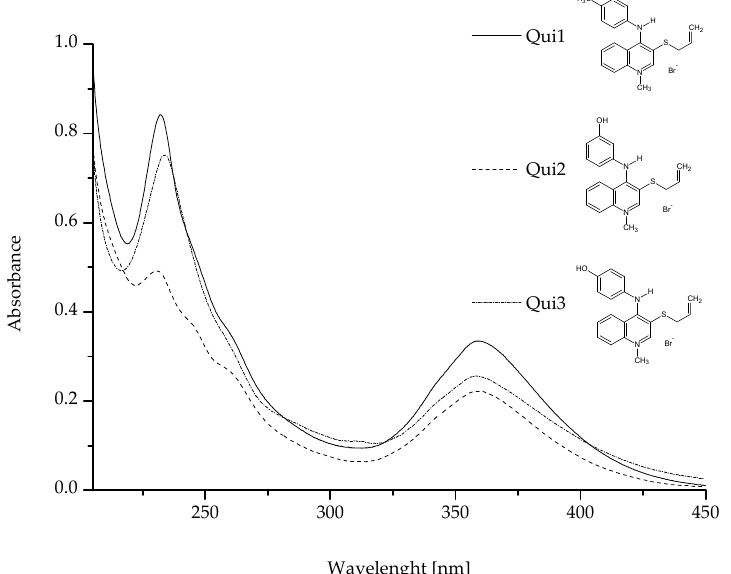
Figure 1. The absorption spectra of Qui1, Qui2 and Qui3 at 2.5 × 10 − 5 M concentration in phosphate buffer (pH = 7.4; 5 × 10 − 2 M). Table 1. The values of Qui1, Qui2 and Qui3 mean molar absorptivity and mean absorbance at 2.5 ×